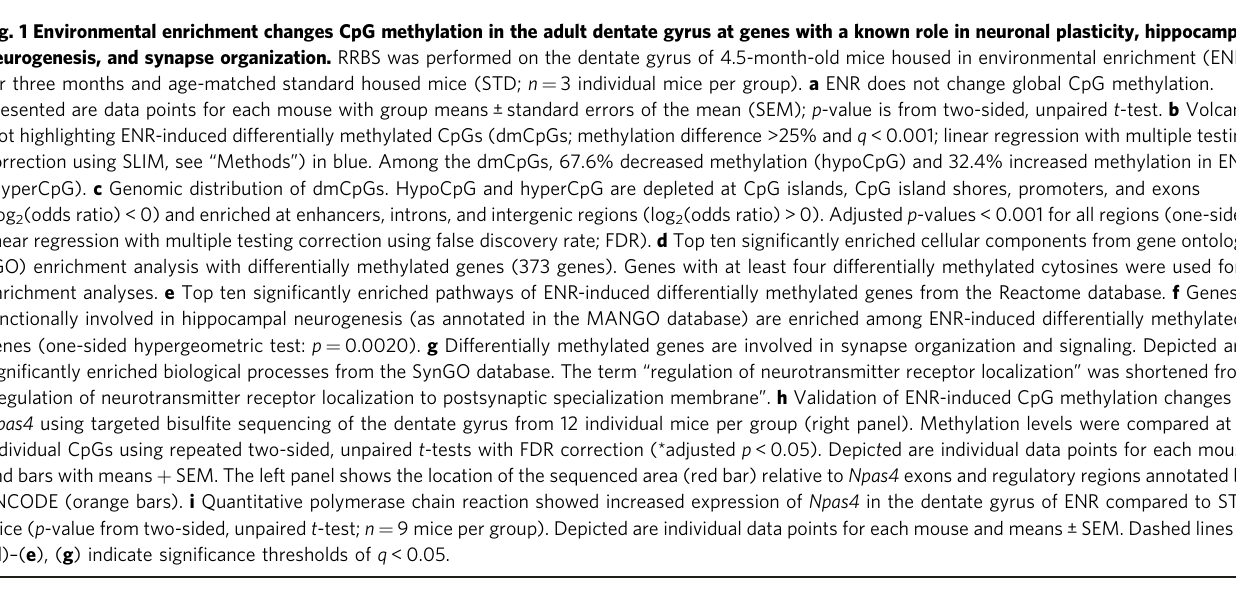
Fig. 1 Environmental enrichment changes CpG methylation in the adult dentate gyrus at genes with a known role in neuronal plasticity, hippocampal neurogenesis, and synapse organization. RRBS was performed on the dentate gyrus of 4.5-month-old mice housed in environmental enrichment (ENR) for three months and age-matched standard housed mice (STD; n = 3 individual mice per group). a ENR does not change global CpG methylation. Presented are data points for each mouse with group means ± standard errors of the mean (SEM); p -value is from two-sided, unpaired t -test. b Volcano plot highlighting ENR-induced differentially methylated CpGs (dmCpGs; methylation difference >25% and q < 0.001; linear regression with multiple testing correction using SLIM, see “ Methods ” ) in blue. Among the dmCpGs, 67.6% decreased methylation (hypoCpG) and 32.4% increased methylation in